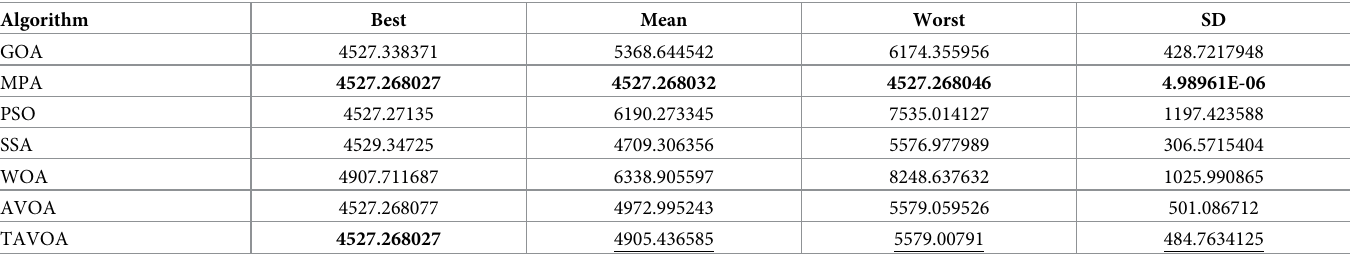
Table 16. Statistical results of pressure vessel design